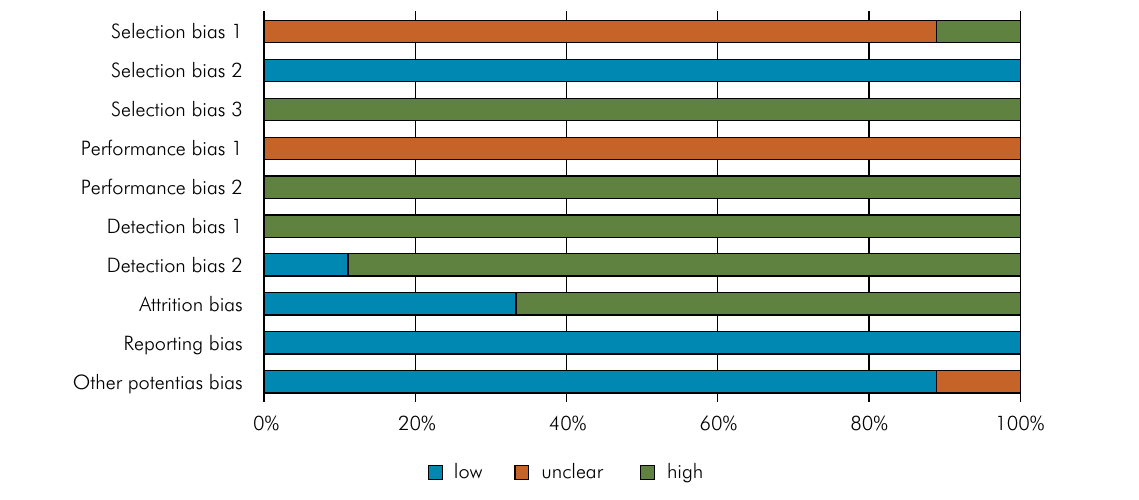
Figure 2. Risk of bias score for each risk item in animal studies, as assessed using the SYRCLE